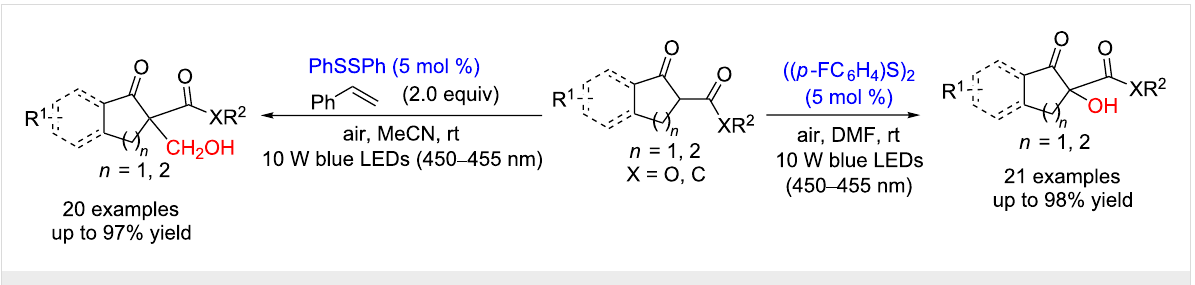
Scheme 10: Disulfide-catalyzed aerobic oxidation of 1,3-dicarbonyl compounds.